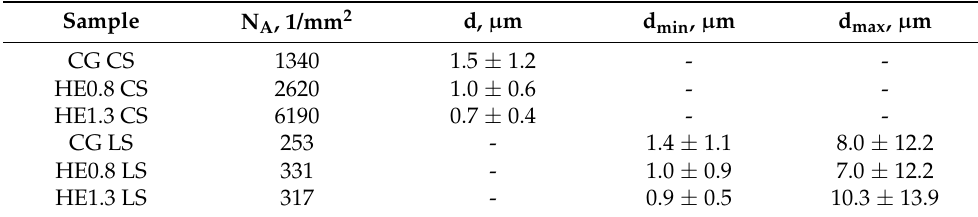
Table 5. Quantitative analysis of inclusions on the cross-section and longitudinal section: N A — number of inclusions, d—average diameter, d min —average minimum diameter, d max —average maximum